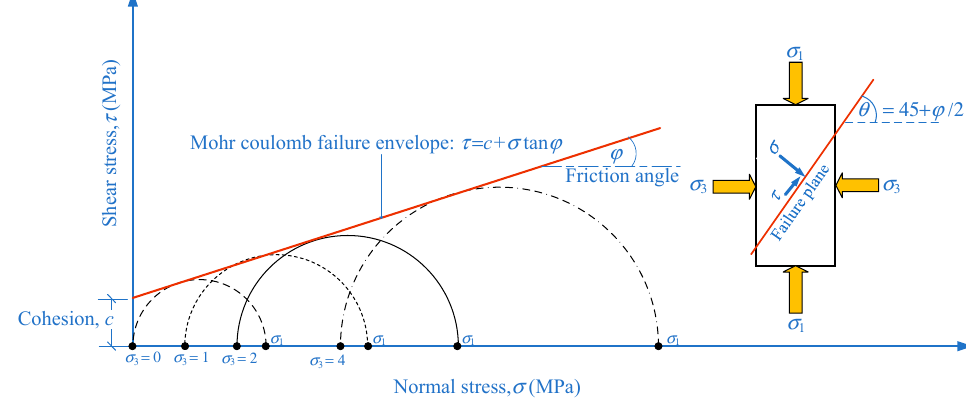
Figure 8. Mohr-Coulomb failure envelope for CFG the samples under triaxial compression tests.